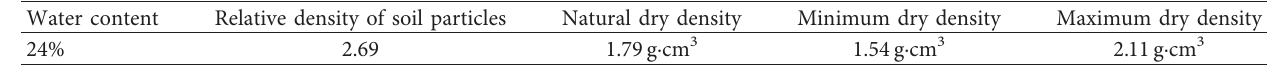
Figure 1: Sampling map. Table 1: Basic physical parameters of gravelly sand.